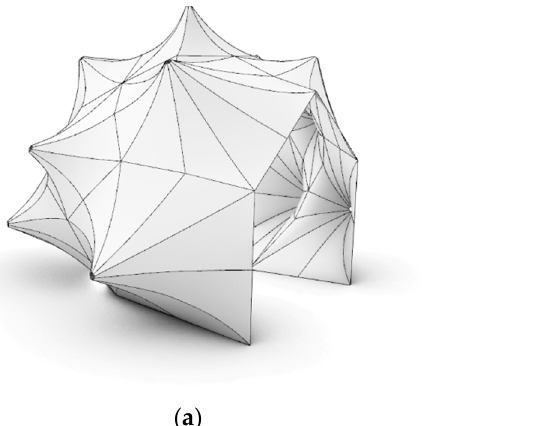
( c ) Figure 13. ( a ) Substructure frames; ( b ) connection between frame halves; ( c ) sandwich frame composition. The membrane, due to budget constraints, technical parameters, and the expected life span of the structure, was made out of Codura, which is a polyester textile additionally